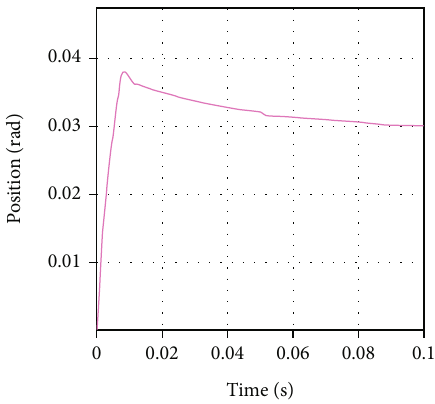
Figure 18: Position estimation errors using LO. Figure 19: Position estimation errors using 2021